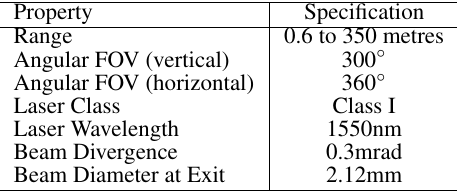
Table 1. Technical Specifications of FARO Focus S